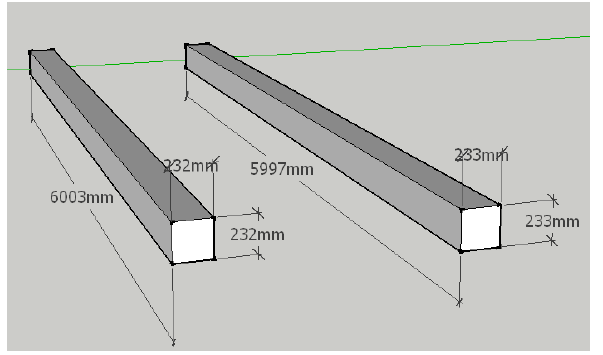
Figure 5. 3D Model Precast Concrete for 230mm x 230mm x 6000mm